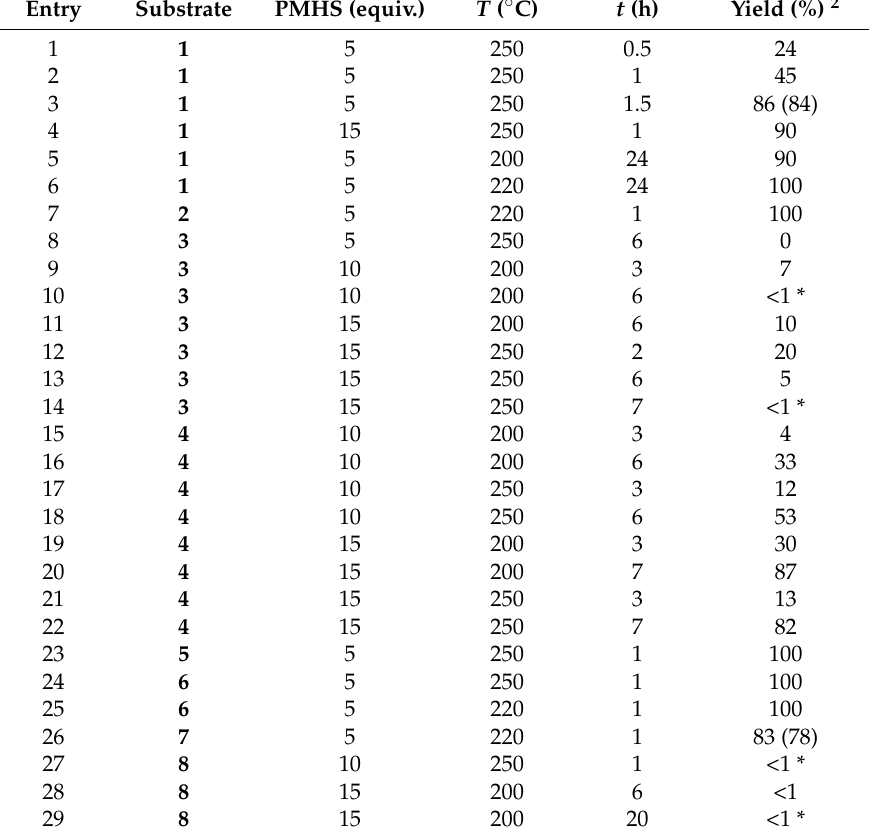
Table 1. Screening of different substrate/PMHS (polymethylhydrosiloxane) ratios, temperatures and reaction times 1